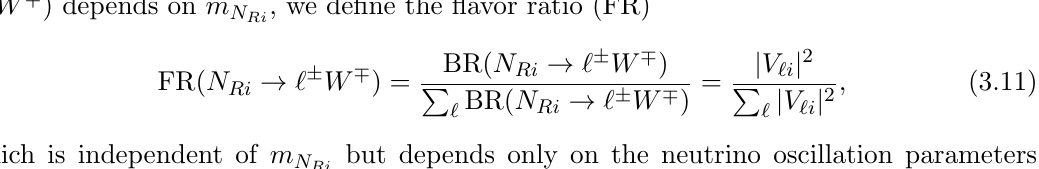
Table 3 . Flavor ratios for heavy Majorana neutrinos N Ri decaying into ‘ (cid:6) W (cid:7) for NH (IH). ‘ (cid:6) W (cid:7) ) depends on m , we de(cid:12)ne the (cid:13)avor ratio N Ri